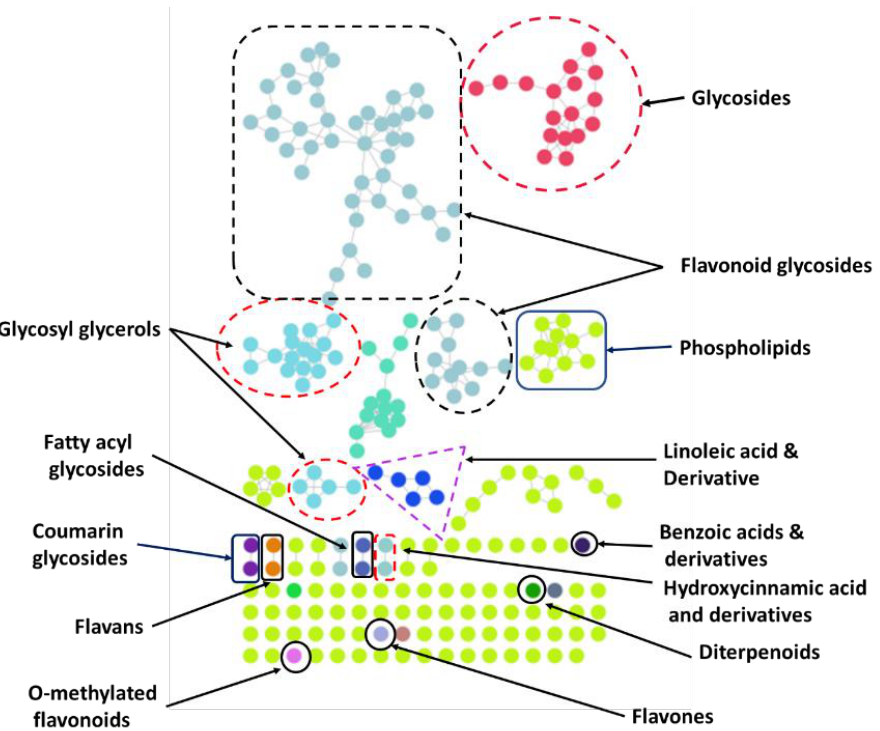
Figure 1. Phytochemical classes of bioactive chloroform fraction from G. velutinum leaves using LC-MS/MS-based molecular networking analysis.